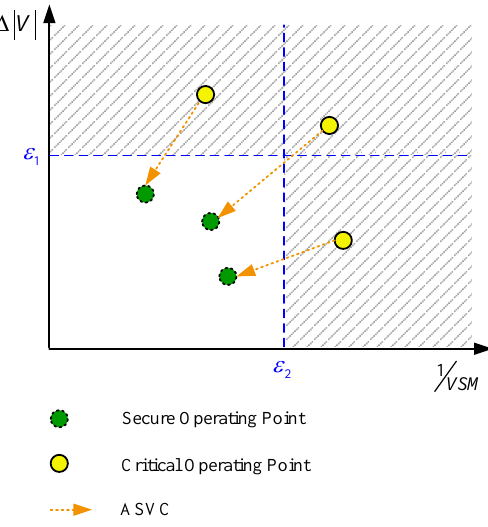
Figure 5. Illustration of the proposed control scheme.